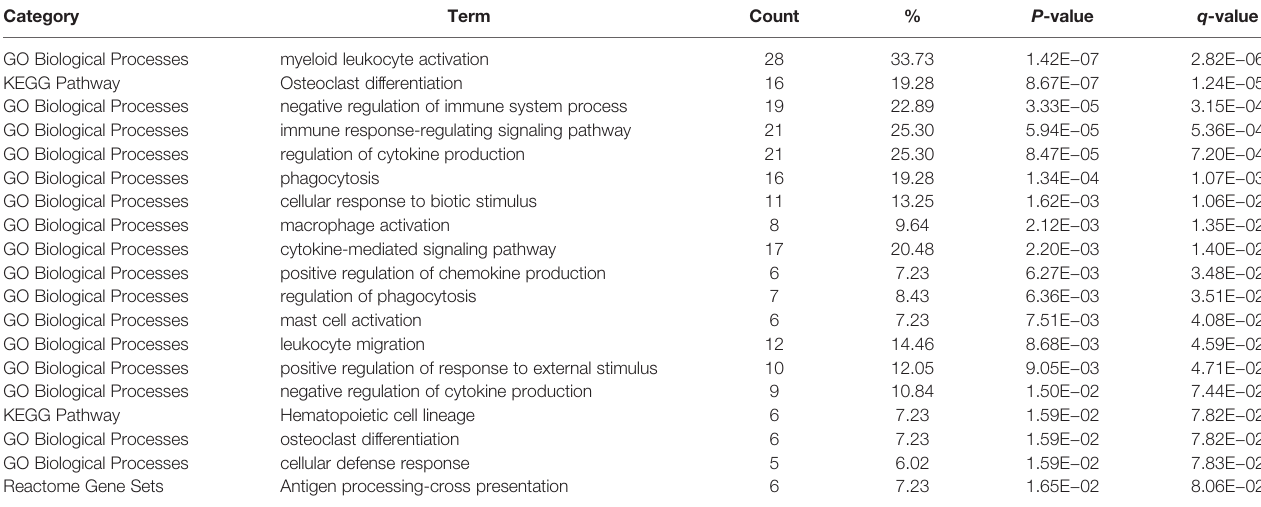
TABLE 2 | Functional enrichment analysis for genes in red